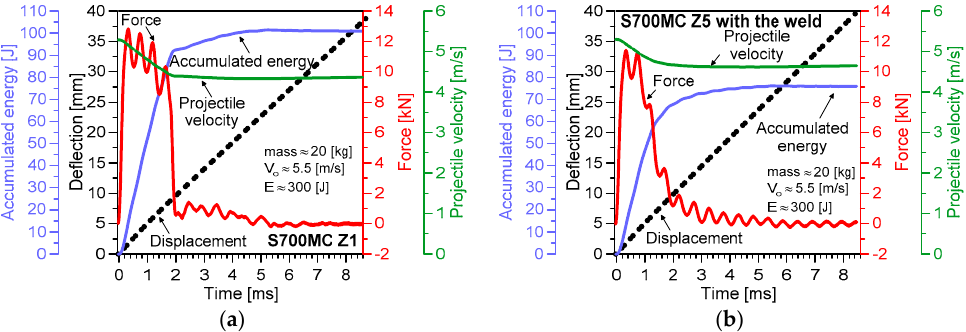
Figure 8. Variations of the Charpy test parameters for the S700MC steel: ( a ) parent material; ( b ) weld (impact energy: 300 J).